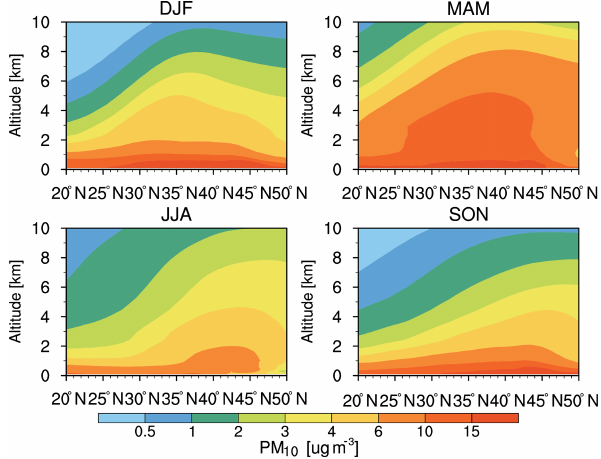
Figure 2. Vertical cross section of zonal-mean aerosol mass con- centration averaged from 120 ◦ E to 120 ◦ W for each season from the WRF-Chem simulation averaged for